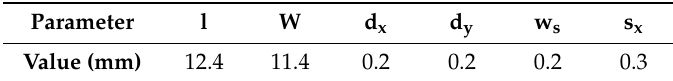
Table 1. Main design parameters.